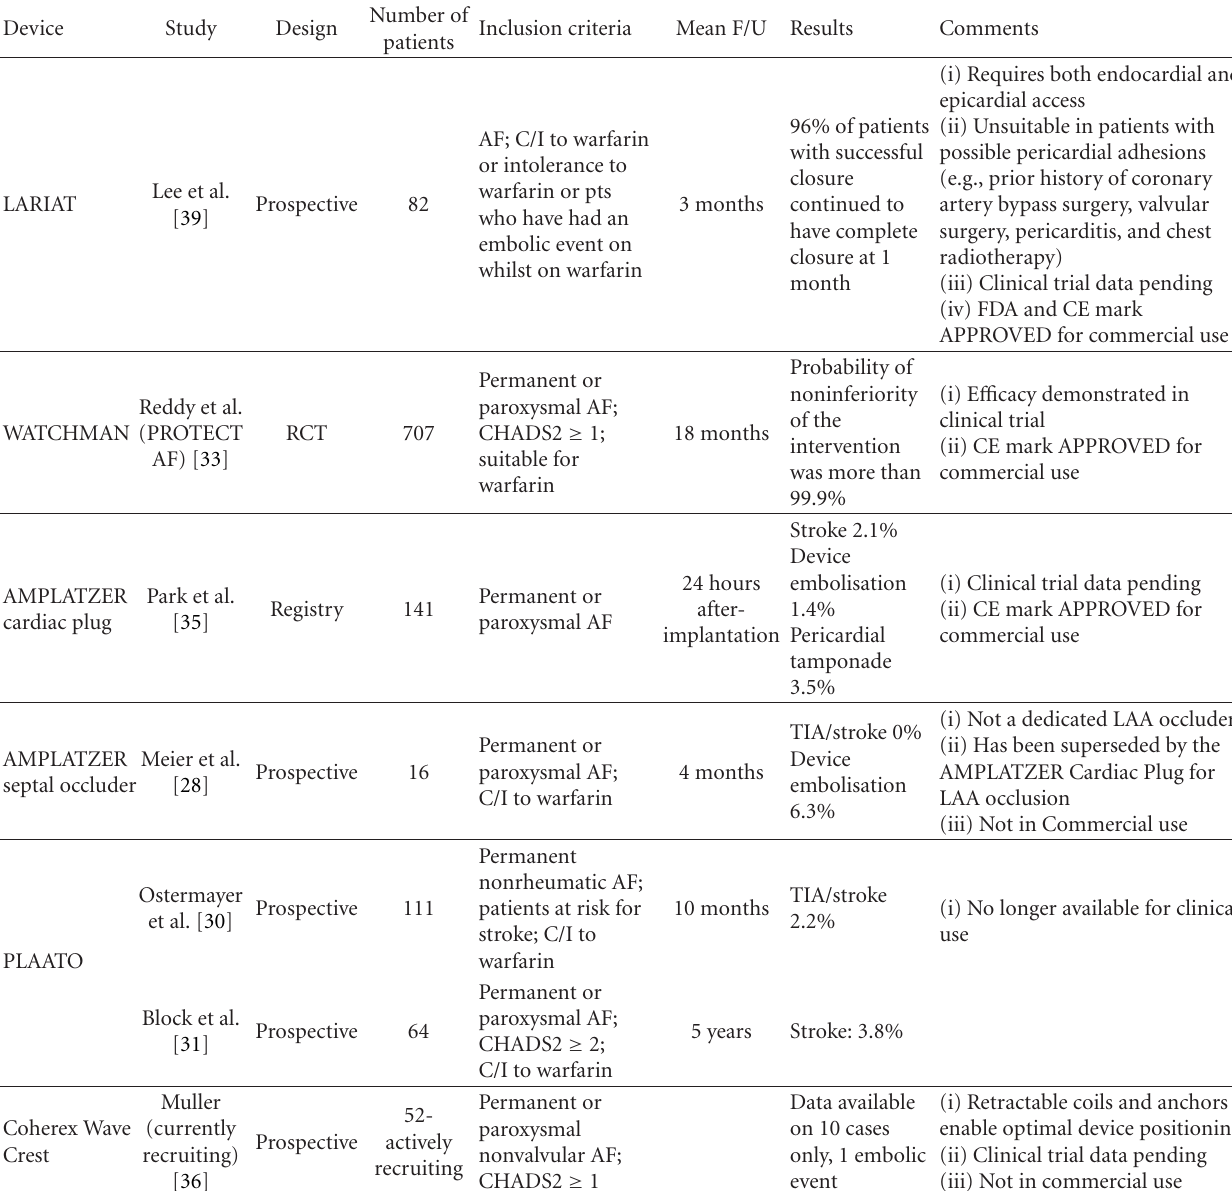
Table 1: Summary of percutaneous